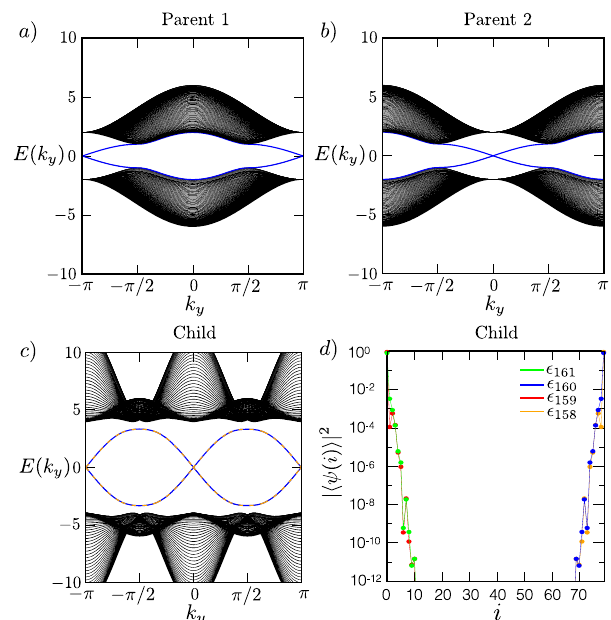
Fig. 5 Emergence of novel phenomena in the child topological phase. a Slab spectrum for the parent Chern insulator with N = 80 layers and open boundary conditions in the ^ x -direction and periodic boundary conditions in the ^ y -direction, with free parameters B and M and B = 2 and M = − 3, showing linearly dispersing topologically protected gapless edge states highlighted in blue crossing at the edge of the slab Brillouin zone. b Slab spectrum for the parent Chern insulator with N = 80 layers and open boundary conditions in the ^ x -direction and periodic boundary conditions in the ^ y -direction, with free parameters B 0 and M 0 and B 0 ¼ 2 and M 0 ¼ (cid:2) 1, showing linearly dispersing topologically protected gapless edge states highlighted crossing at the center of the slab Brillouin zone. c Slab spectrum for the multiplicative Chern insulator constructed from the Chern insulators whose slab spectra are shown in a and b , with N = 80 layers and open boundary conditions in the ^ x -direction and periodic boundary conditions in the ^ y -direction. The two-fold degenerate bands corresponding to topologically protected gapless edge states are highlighted as dashed orange and blue lines. The step size for a , b , and c in k -space is 0.01. d Probability density ∣ 〈 ψ ( i ) 〉 ∣ 2 vs. layer index i for each of the four edge states computed for k y = π /4 in the slab spectrum shown in c , with the two states lower in energy labeled as ϵ 158 (orange) and ϵ 159 (red), and the two states higher in energy labeled as ϵ 160 (blue) and ϵ 161 (green), showing localization of each state at an edge of the slab. We also see that each edge possesses two counter-propagating edge states as expected for a time- reversal invariant